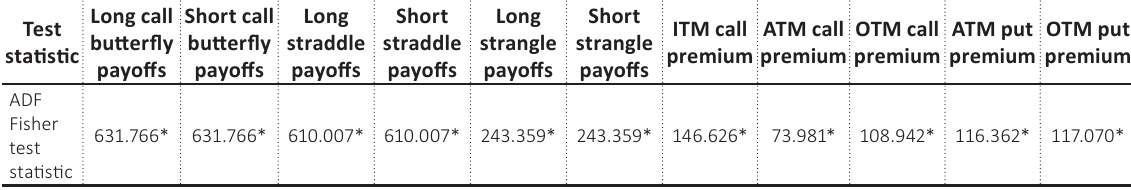
Table 2. Augmented Dickey-Fuller test results